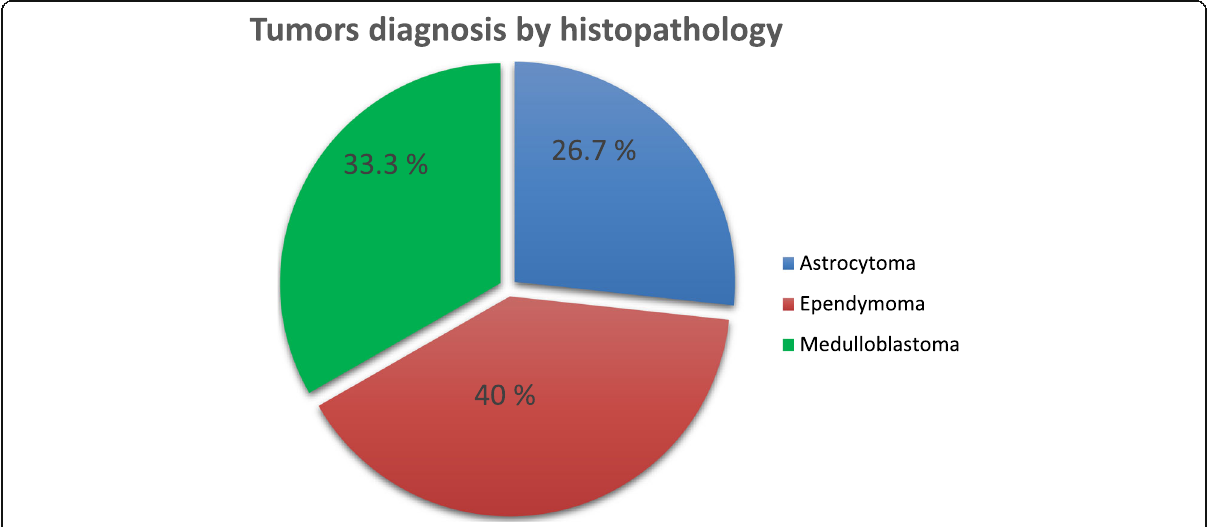
Fig. 1 Distribution of posterior fossa tumors among the studied cases ( n = 30)